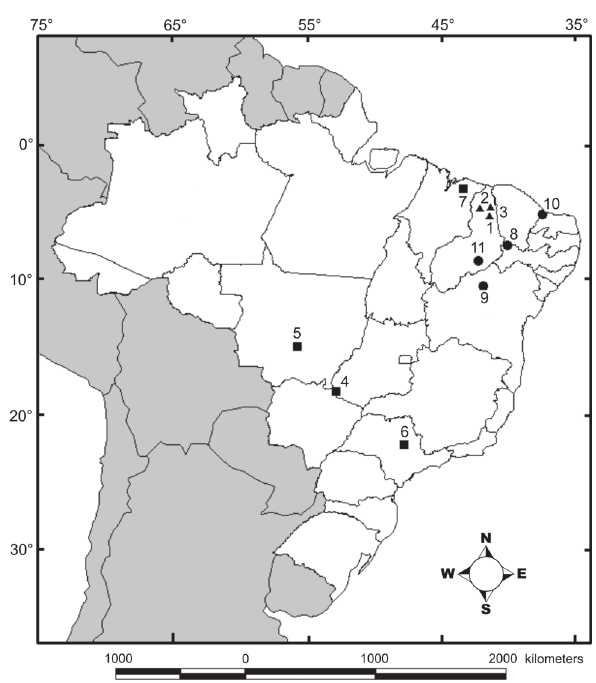
Figure 1. Cerrado, Caatinga and Cerrado-Caatinga transition lo- calities used for comparisons regarding snake assemblages. Sub- title: Cerrado-Caatinga transition: (01) Castelo do Piauí, State of Piauí; (02) José de Freitas, state of Piauí; (03) Parque Nacional de Sete Cidades (PNSC), state of Piauí. Cerrado: (04) Parque Nacional das Emas, state of Goiás; (05) Manso hydroelectric powerplant, state of Mato Grosso; (06) Itirapina, state of São Paulo; (07) Urbano Santos, state of Maranhão; (08) Exu, state of Pernambuco; 09) Dunas de São Francisco, state of Bahia. Caatinga: (10) Chapada do Apodi, state of Ceará and Rio Grande do Norte, and (11) Parque Nacional Serra da Capivara, state of